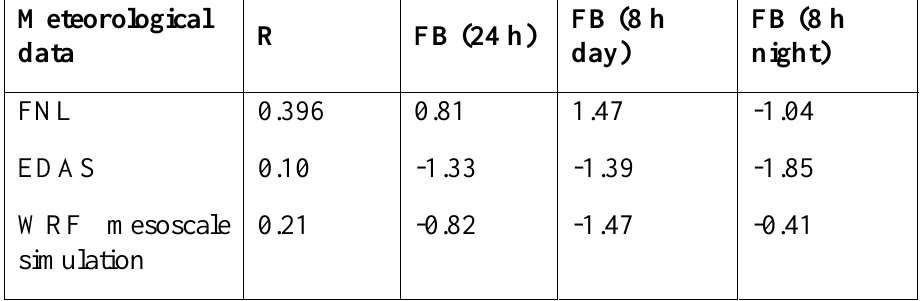
Table 5. Results of dispersion calculations with FNL, EDAS and WRF meteorological data. R- correlation coefficient, FB- fractional